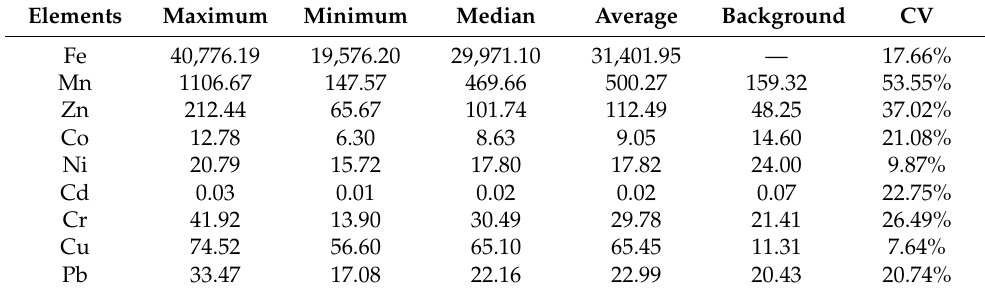
Table 3. Values of maximum, minimum, median, average, background (in mg/kg), and coefficient of variation (CV%) for total concentration of heavy metals in the surface sediments from the Qinjiang River. Elements Maximum